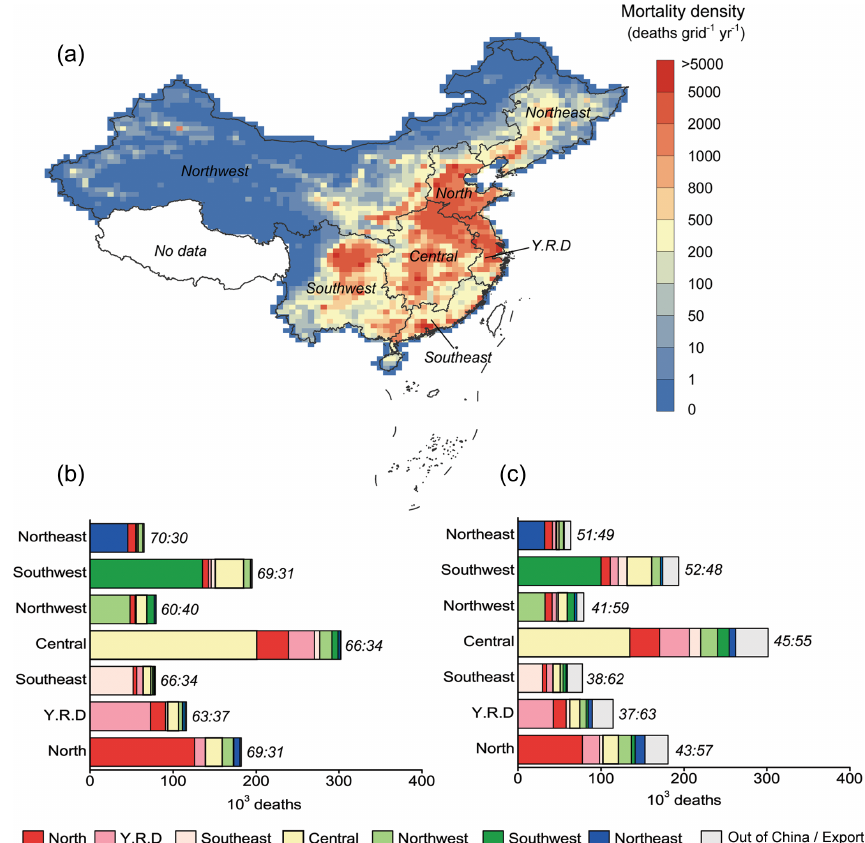
Figure 2. Anthropogenic PM 2 . 5 -related premature deaths in China for 2010 at the 0 . 5 ◦ × 0 . 667 ◦ horizontal resolution (a) , and regional premature deaths attributed to regions where emissions were produced (b) and regions where products were ultimately consumed (c) . Datasets at the end of each bar mean the percentages of regional premature mortality attributed to local source and the percentages attributed to other regions. Y.R.D. is the Yangtze River